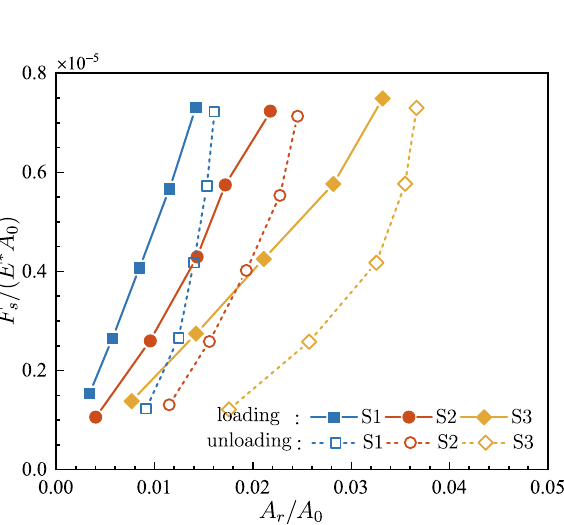
Figure 9. The dimensionless maximum static friction force F s /( E*A 0 ) under various contact fractions A r / A 0